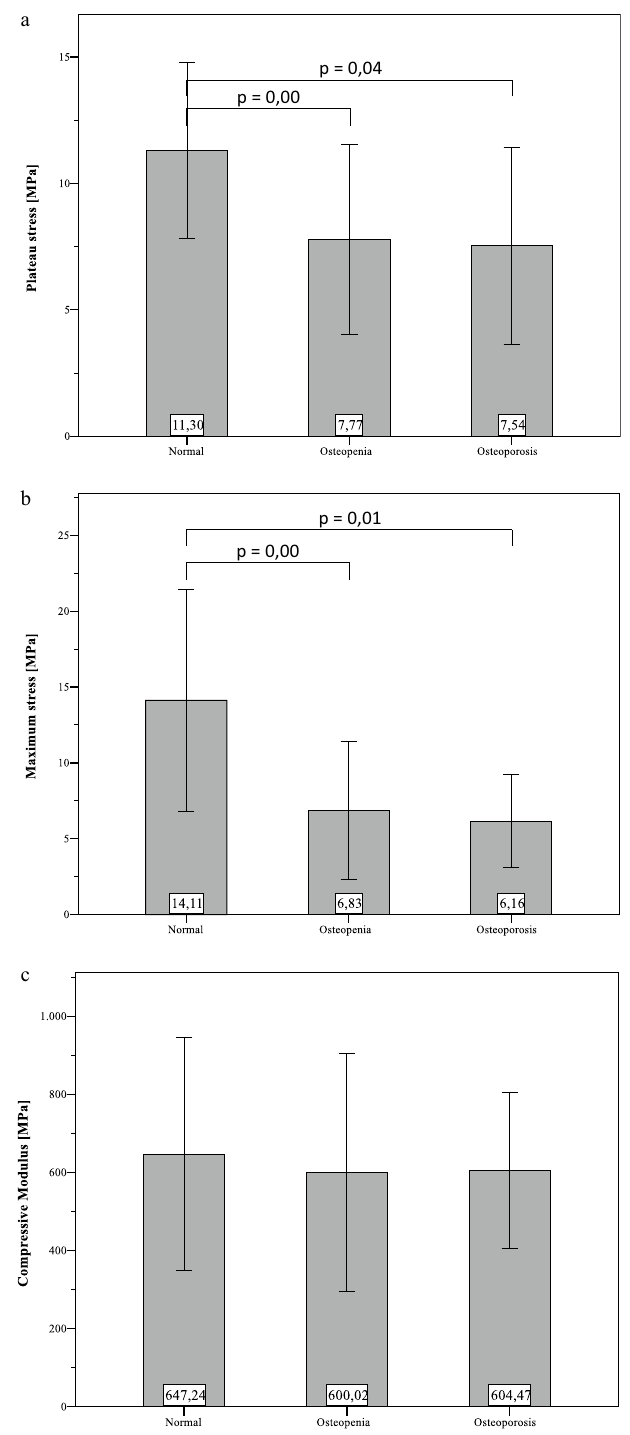
Figure 5. Mean values (with standard deviation) of the determined mechanical properties, grouped regarding WHO classification for osteoporosis based on BMD measurements of each donor bone. There are no significant differences in all mechanical properties (σ p , σ max , E) between “osteopenia” and “osteoporosis”. Significant differences within presented groups are marked with their specific p-value from independent